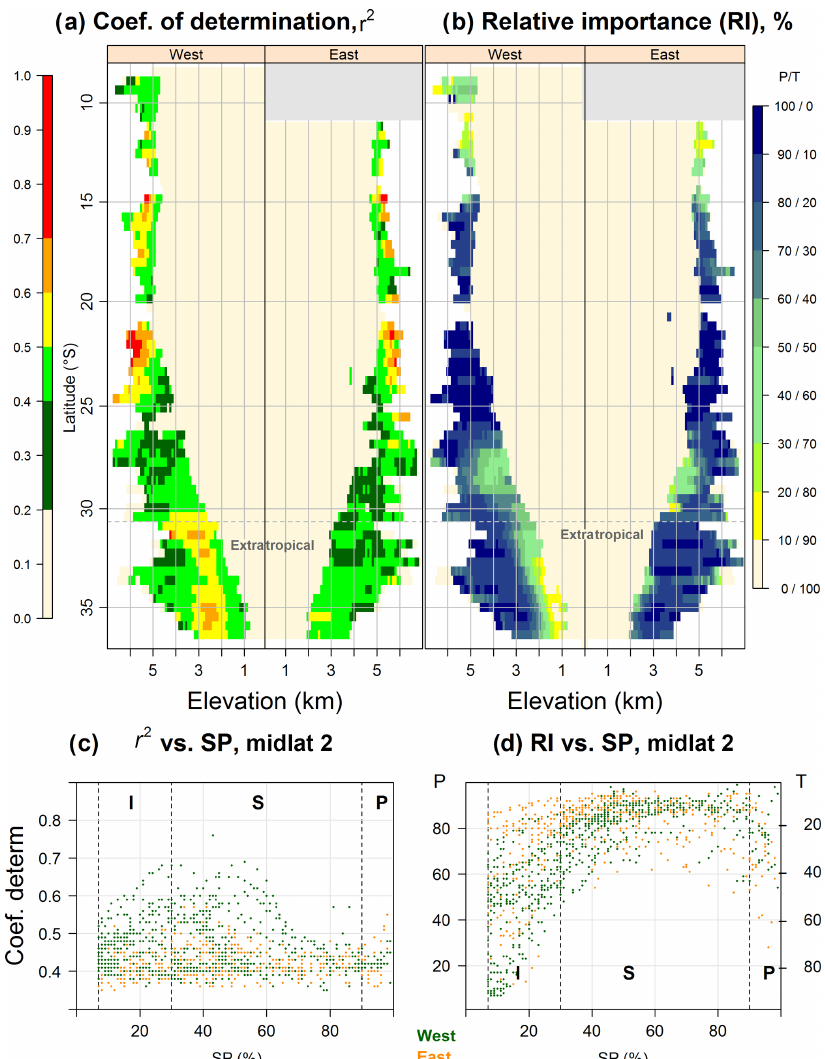
Figure 11. Latitude–elevation band analysis of the side of the continental divide (west–east) for (a) coefficient of determination ( r 2 ) for multiple linear regression using annual precipitation and mean air temperature to predict SP from 2000 to 2016 and (b) relative importance (RI) of P /T . Gray areas represent latitudes masked due to high frequency of cloud cover in snow-covered area analysis ( > 30% period). (c) r 2 vs. SP and (d) RI of P /T in midlatitude 2 snow region for west (green) and east (orange) vs. SP values. Vertical dashed gray lines inside inset boxes represent thresholds for intermittent (I), seasonal (S), and persistent (P) snow